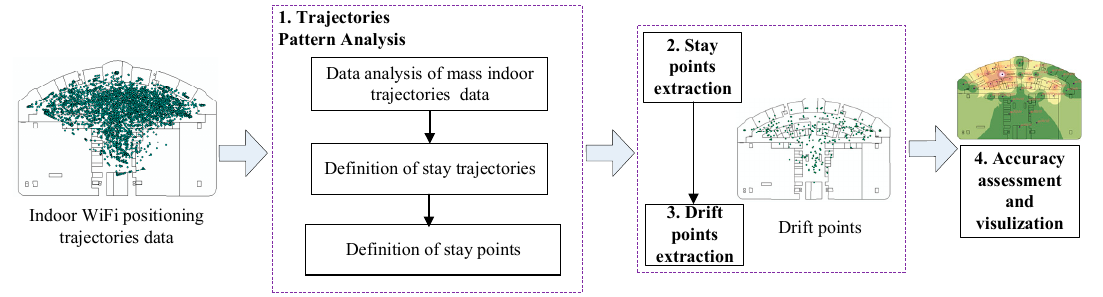
Figure 2. The technical framework of the proposed approach.